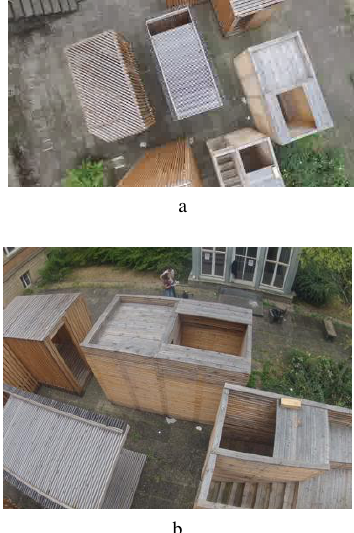
Figure 4. Evaluation image (a) of the low coverage sequence and its nearest training image (b) according to BoVW. A feature matching between these two images could not be determined suf- ficient due to low number of corresponding image